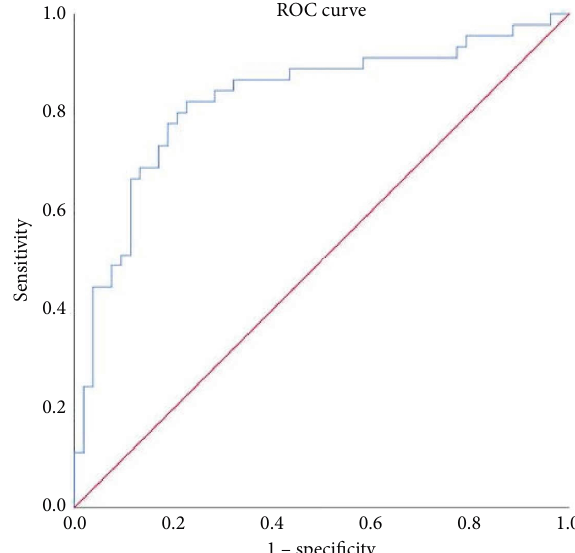
0.0 Figure 2: ROC curve drawn by LYMPH#, HFLC#, IG#, NE-WX, LY-WX, LY-WY, and